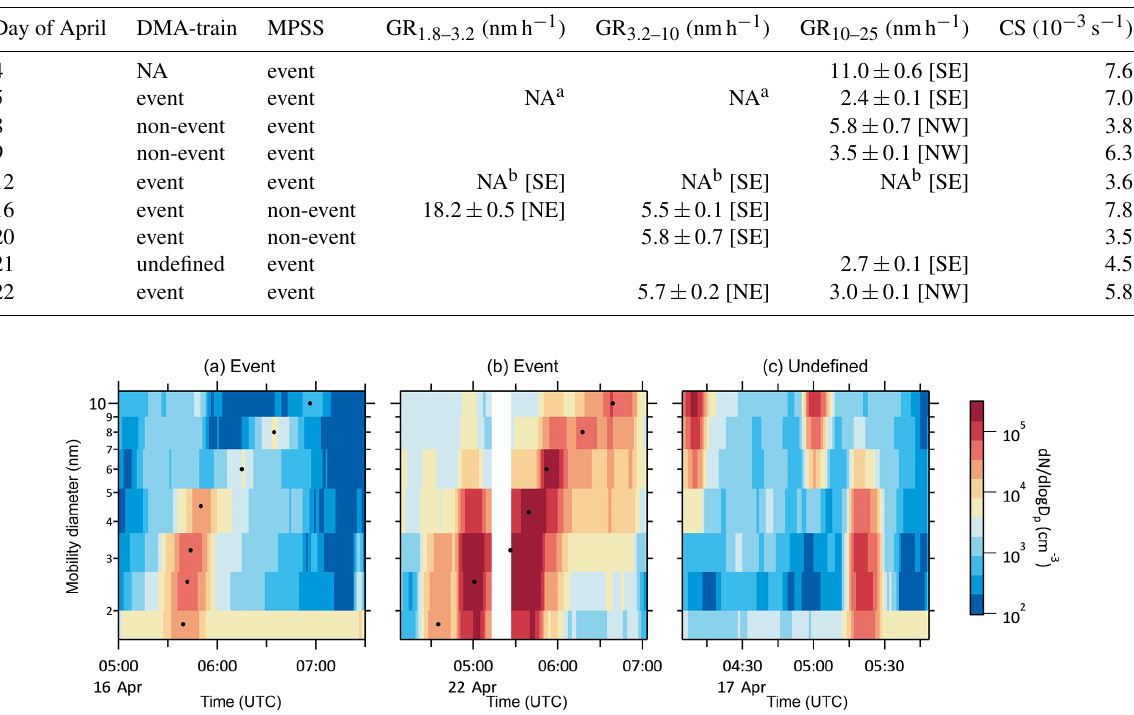
Table 1. Results of the event classification during the measurement period from 3 to 30 April 2017. Days on which an event day was classified either in the DMA-train or in the MPSS are displayed. Growth rates from the DMA-train data in two size intervals (1.8–3.2 and 3.2–10nm) and from MPSS data in one size interval (10–25nm) are listed here with the prevailing wind direction during the growth in brackets. On 5 April 2017, the growth rate analysis was impossible due to insufficient DMA-train data availability during the event (NA a ). Strong fluctuations in the number size distribution did not allow the growth rate to be inferred on 12 April (NA b ). The mean condensation sink (CS) was averaged over the course of the event period and is added here.